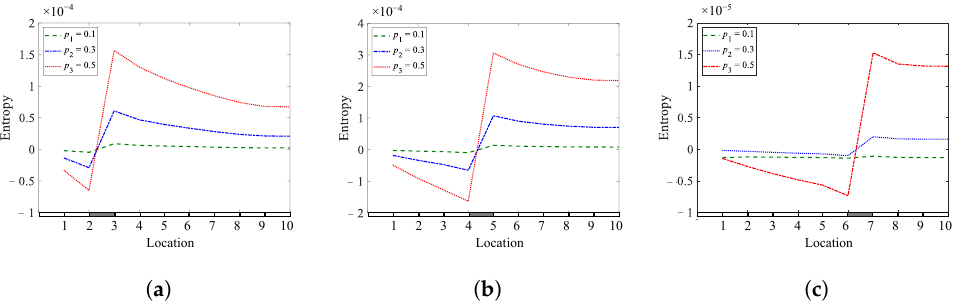
Figure 15. Entropy of a cantilever, simply supported beam for different crack depths and locations: ( a ) q 1 = 0.25; ( b ) q 2 = 0.45; ( c ) q 3 = 0.65.